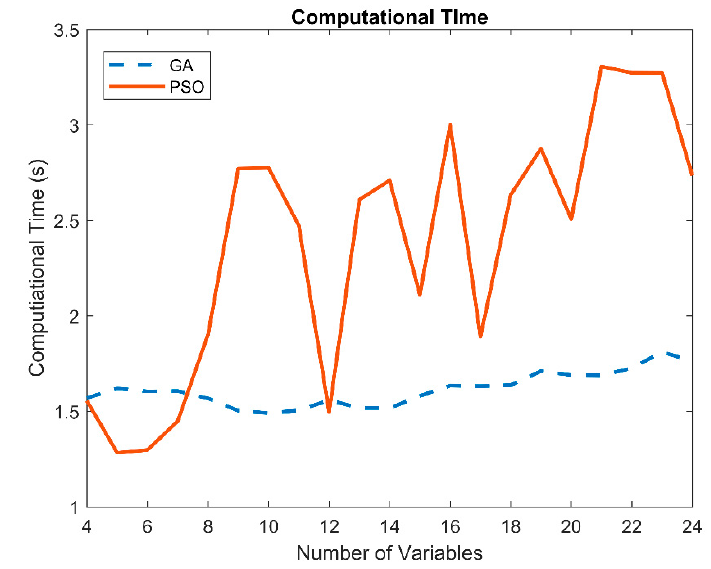
Figure 14. Computational time comparison between the PSO and the GA using the parameters of the sensitivity analysis.